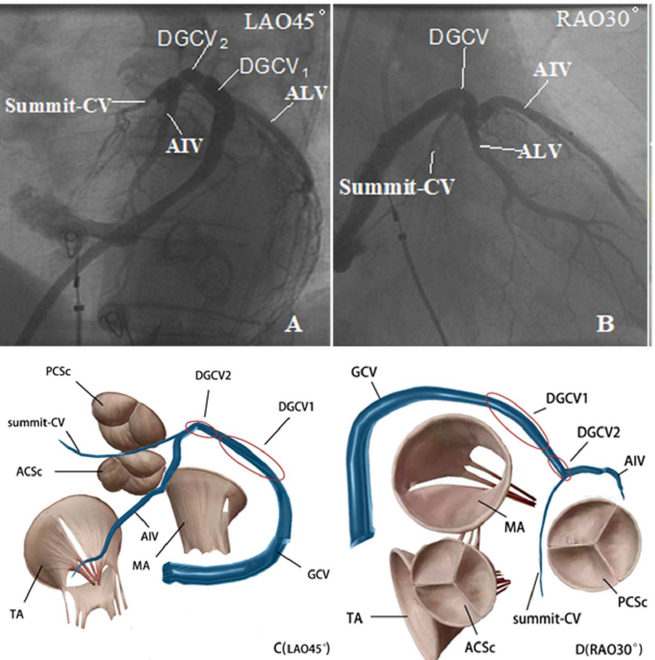
Figure 5. The X-ray imaging and anatomy of TAODGCV. ( A , B ) are the X-ray imaging of TAODGCV. ( C , D ) are anatomical diagrams of TAODGCV. The red ovals indicate the range of DGCV1 and DGCV2 defined in this study. TAODGCV = transitional area of the distal great cardiac vein; DGCV1 = distal great cardiac vein 1; DGCV2 = distal great cardiac vein 2; GCV = great cardiac vein; AIV = anterior interventricular vein; Summit-CV = summit communicating vein at the top of the left ventricle; TA = tricuspid annulus; MA = mitral annulus; ALV = anterior lateral vein; LAO = left anterior oblique position; RAO = right anterior oblique